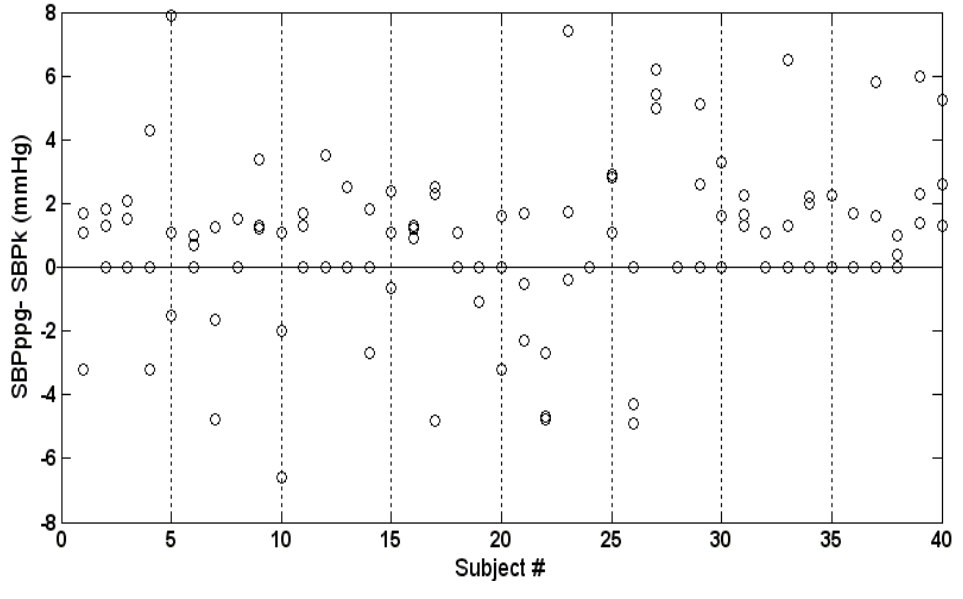
Figure 7. Intra-subject variability. The figure presents the three values of SBP each